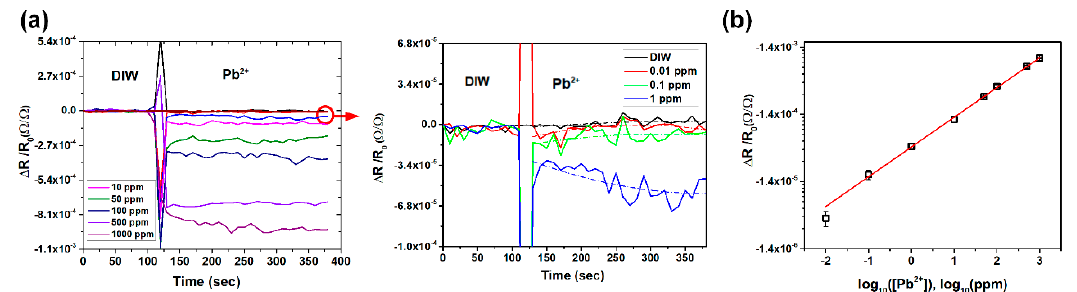
Figure 3. ( a ) Signal responses of PEDOT:PSS-modified CMOS MEMS-based nanomechanical sensors in solutions with different concentrations of lead ions and ( b ) the analysis of the linear relationship between the logarithmic signal response of the sensor and the logarithmic concentration of lead ions.